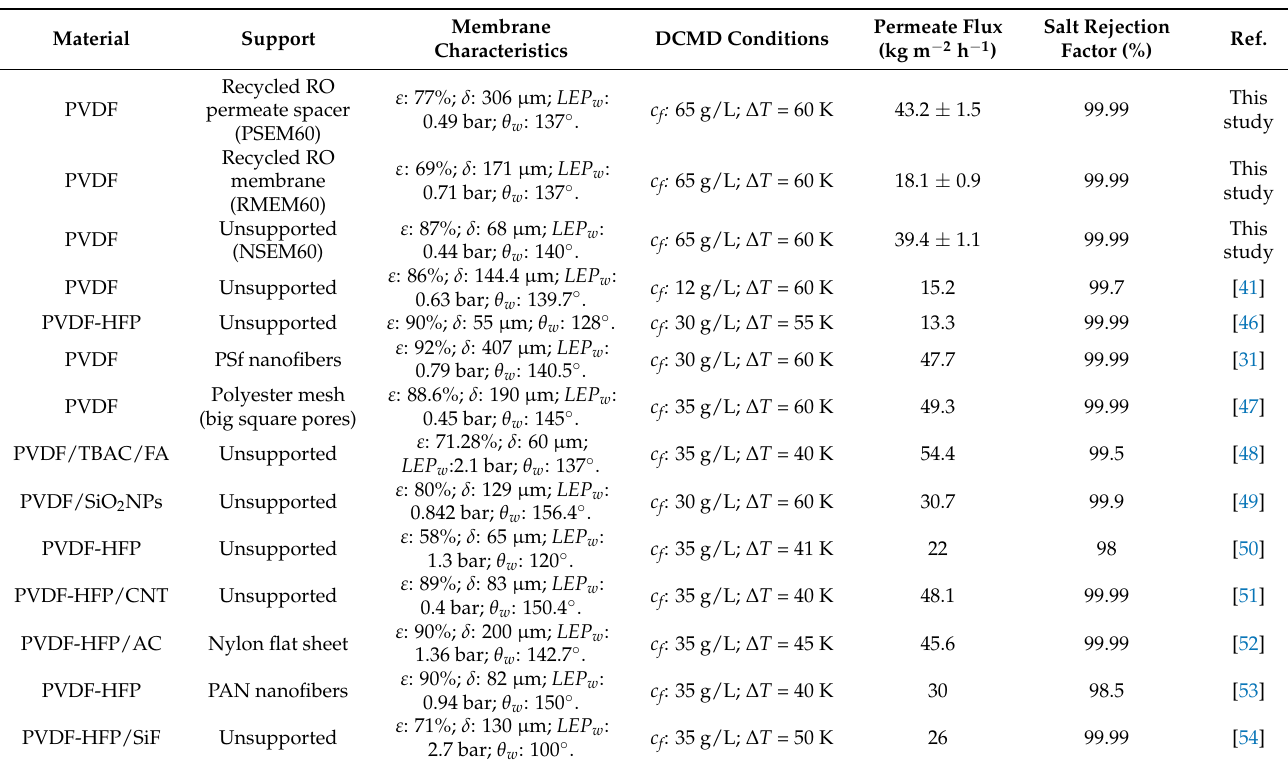
Table 4. DCMD performance and characteristics of optimized electrospun nanofibrous membranes reported in other studies together with the best ones obtained in the present study for the supported PVDF nanofibrous membranes using the recycled RO membrane (RMEM60) and the permeate spacer (PSEM60), and the unsupported PVDF nanofibrous membrane (NSEM60).